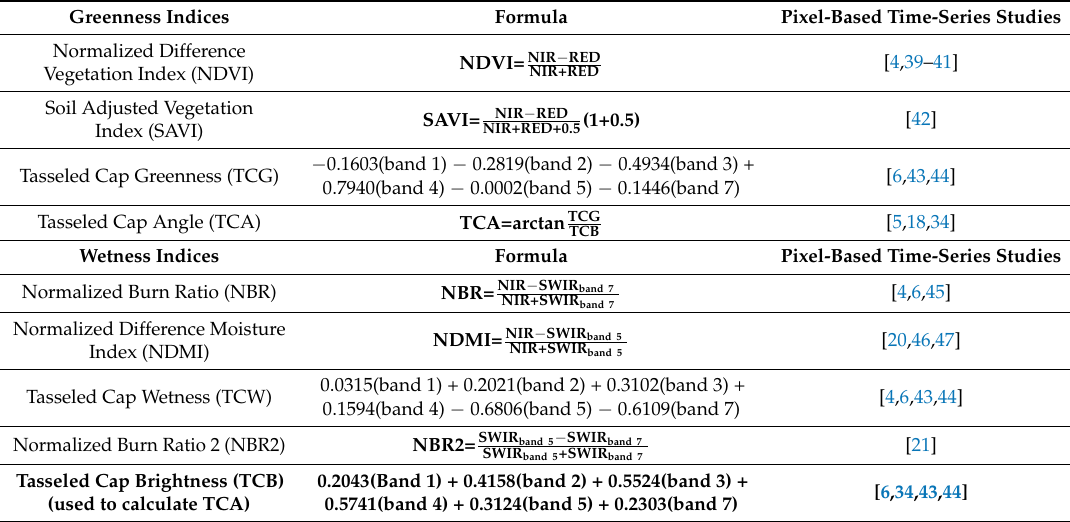
Table 2. Landsat spectral indices used in this paper, and a selection of pixel-based time-series studies using these indices (band numbers refer to Landsat TM and ETM+